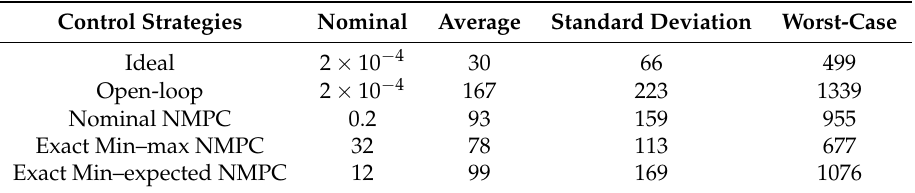
Table 1. The robust performance (value of cost ) of different control strategies evaluated using 100 test scenarios and exact information.